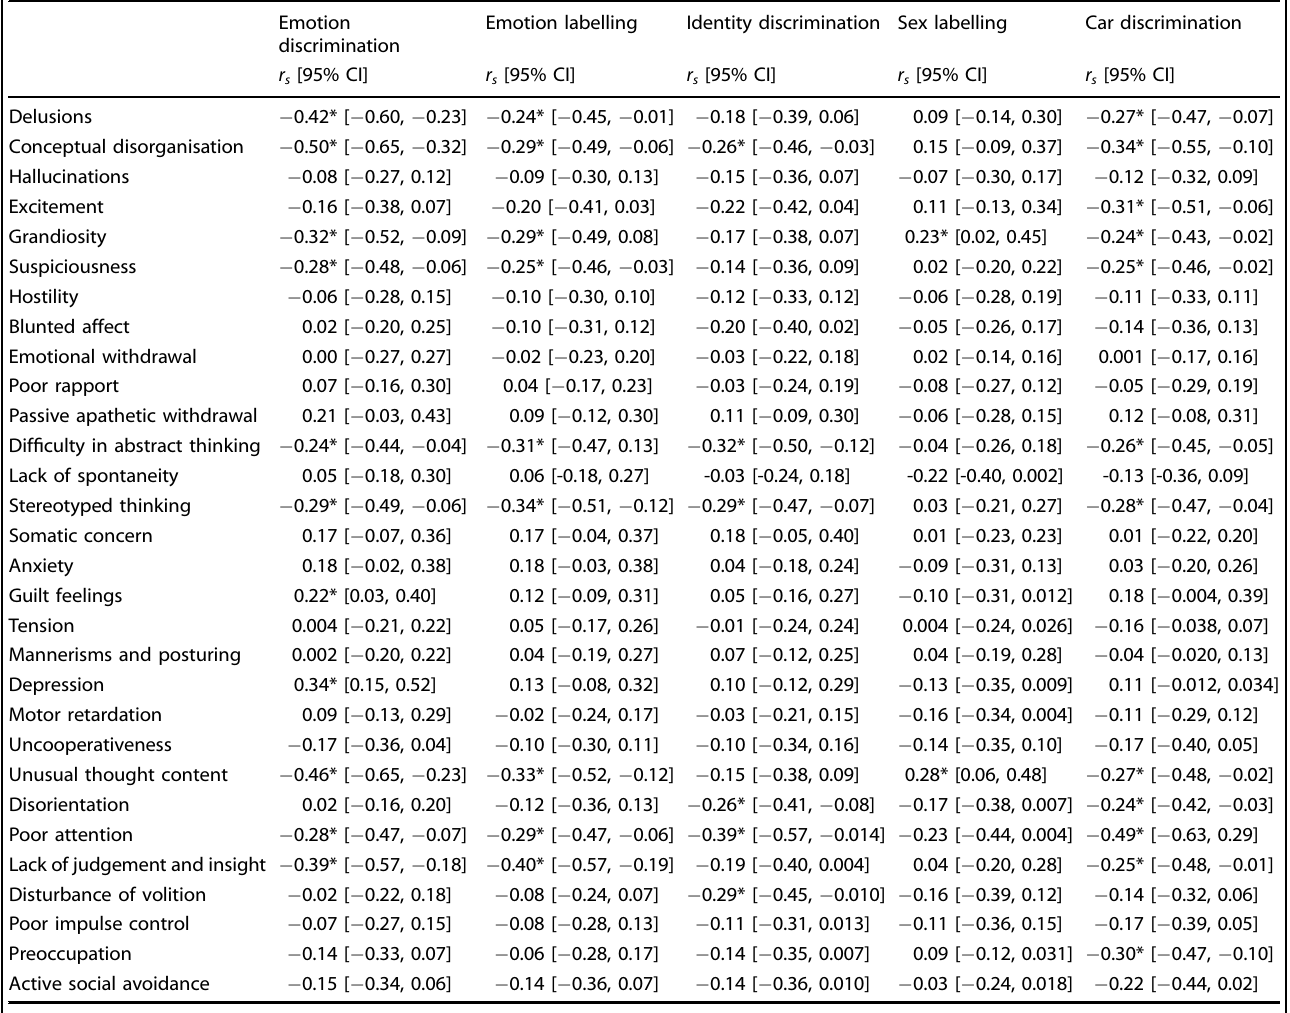
Table 3. Spearman rank correlations between individual PANSS items and d prime performance on the fi ve dynamic tasks. Emotion Emotion labelling Identity discrimination Sex labelling Car discrimination